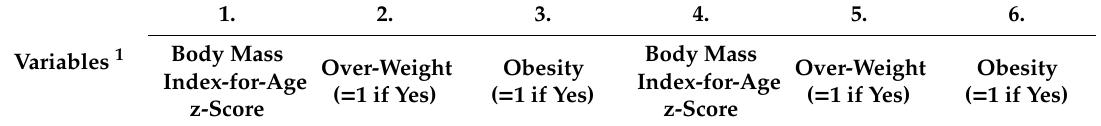
Table 7. Heterogeneity in the correlation between DDS and nutrition outcomes by family